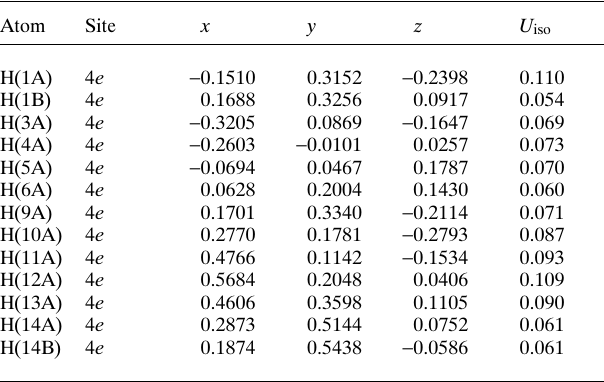
Table 2. Atomic coordinates and displacement parameters (in Å 2 )